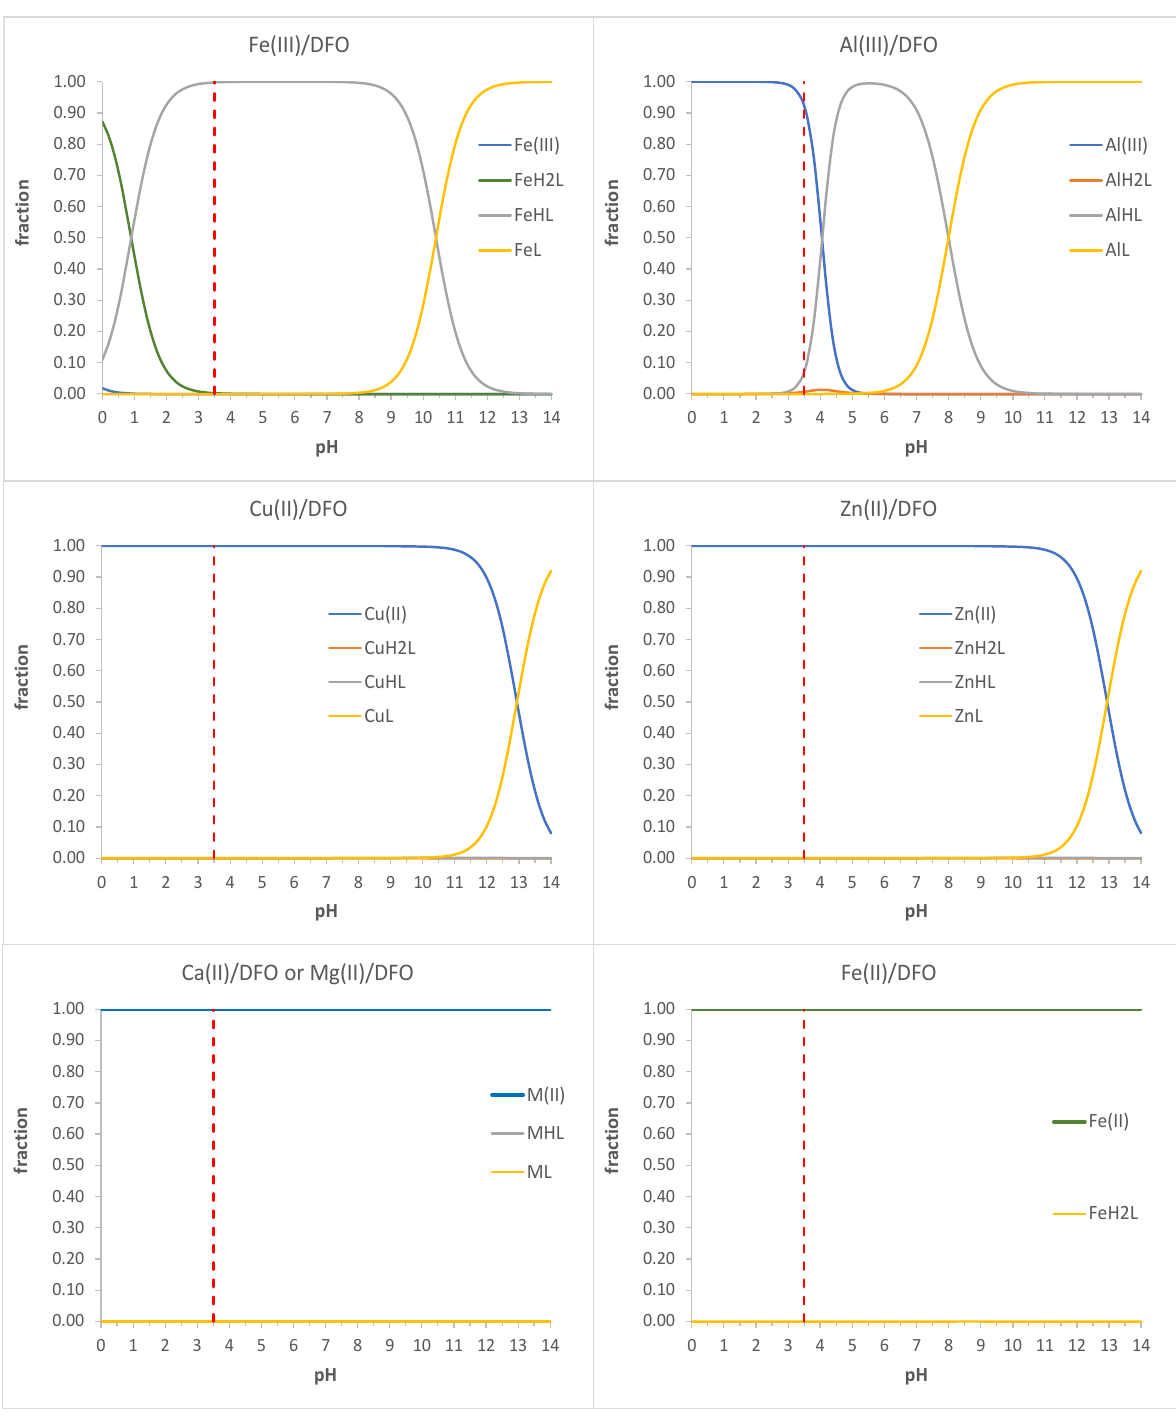
Figure 8. Distribution diagrams for the systems Fe(III)/DFO, Al(III)/DFO, Cu(II/DFO; Zn(II)/DFO, Ca(II)/DFO, Mg(II)/DFO, Fe(II)/DFO, at 25 °C and I = 0.1 M. Protonation and complexation constants obtained from ref. [50].